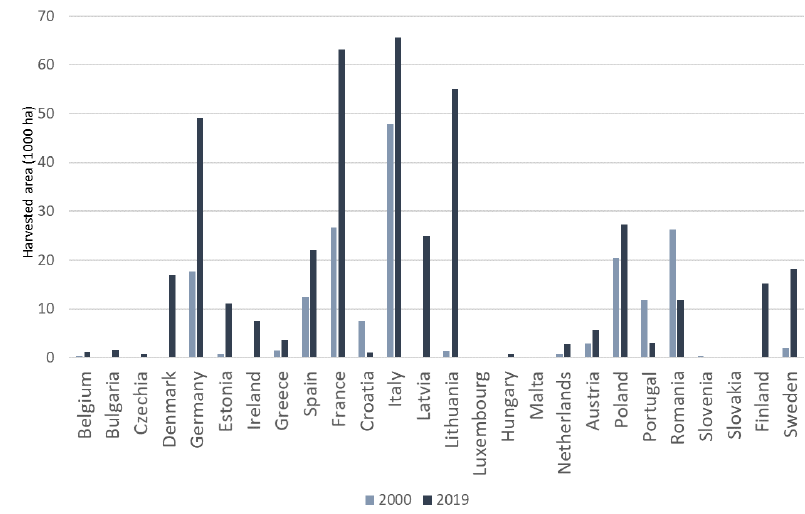
Figure 9. Harvested area of field bean in EU countries in 2000 and 2019 [46].